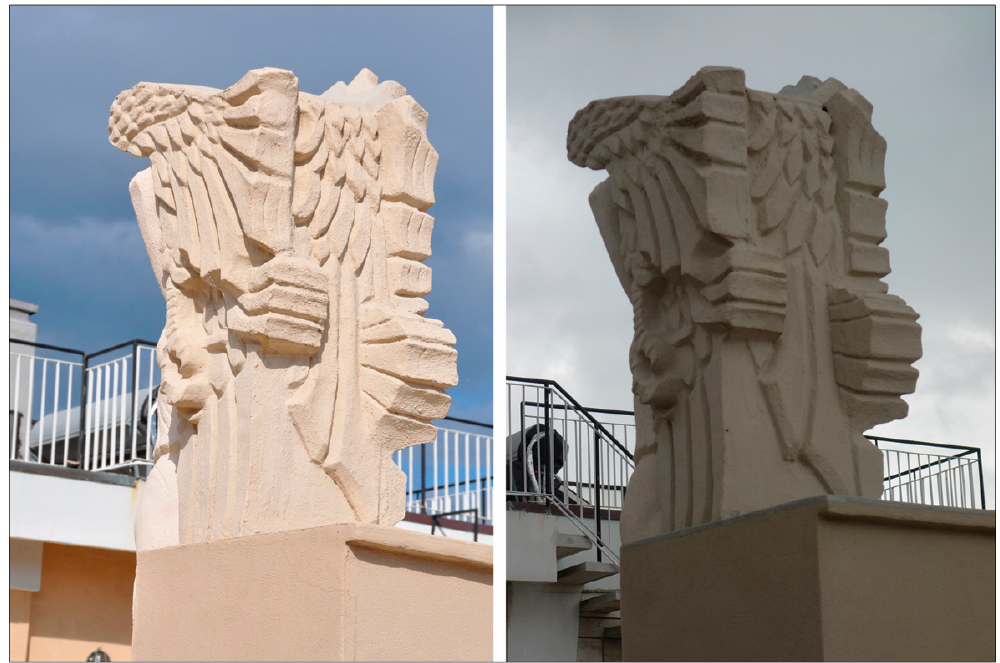
Figure 4. The photos show the strong color difference between first and second survey